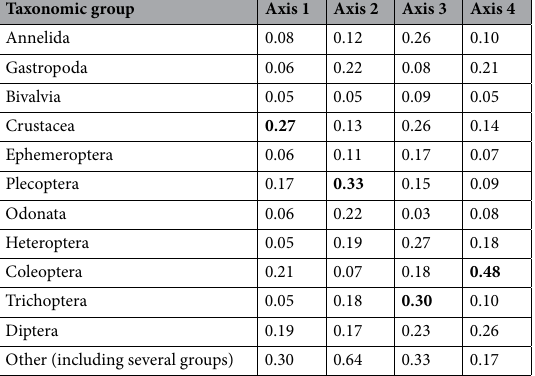
Table 2. The variance of taxonomic groups along the first four PCA axes. Highest values are highlighted in bold (excluding the “other” group).